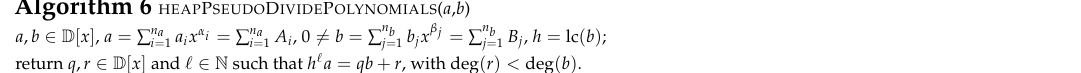
Algorithm 6 HEAP P SEUDO D IVIDE P OLYNOMIALS ( a , b